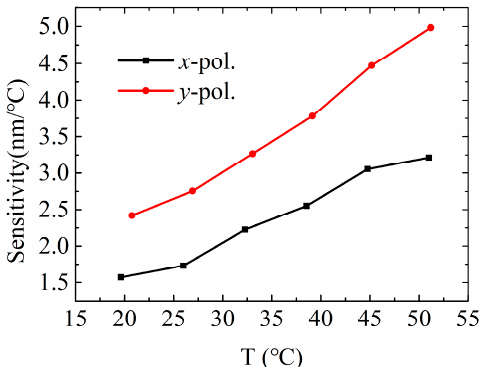
Figure4. Temperaturesensitivitiesofthe x -polarizedand y -polarizedcoremodesatdifferenttemperatures. Figure 4. Temperature sensitivities of the x -polarized and y -polarized core modes at different temperatures. Table 1. Sensitivity comparison of various fiber optic temperature sensors. Table 1. Sensitivity comparison of various fiber optic temperature sensors.